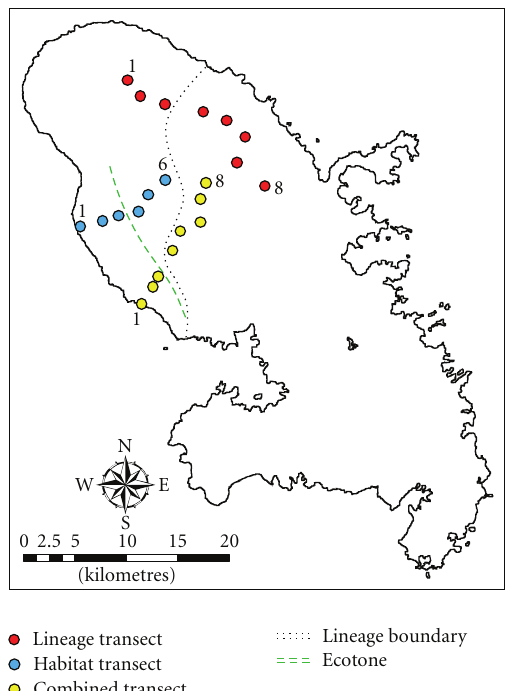
Figure 1: Map of the sampled populations. The lineage transect is indicated in red, the habitat transect in blue, and the combined transect in yellow. The first and last sites of each transect are numbered on the